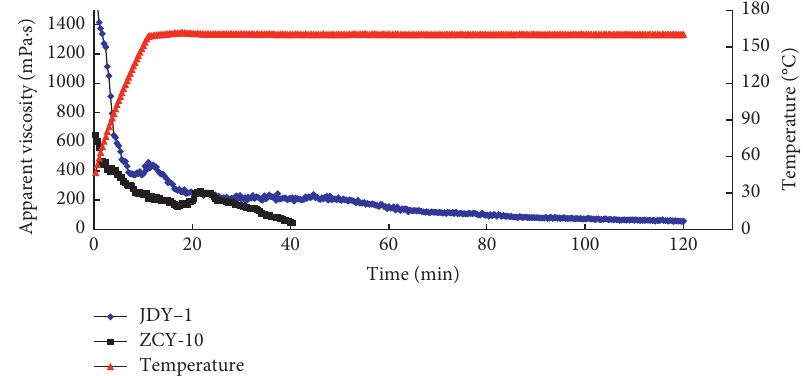
Figure 3: Temperature and shear resistance of the high-density fracturing fluid at 160 ° C and 170s − 1 . Table 5: Crosslinking performance of fracturing fluids with different densities.